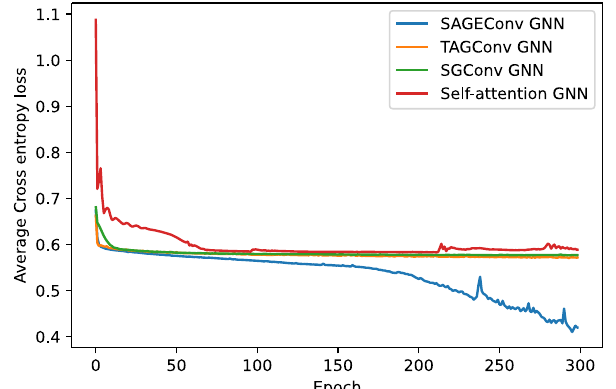
Figure 3. The processes aim at the three-category classification, in which “self-attention GNN” still means our improved